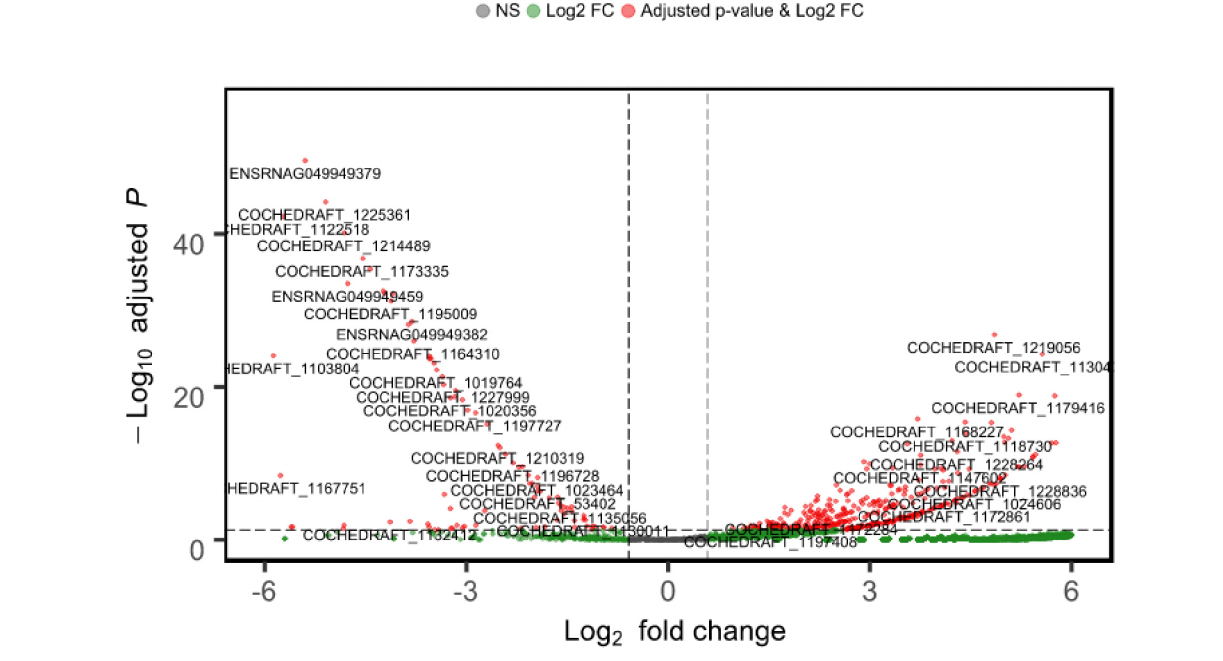
FIGURE 3 | Mean expression versus log fold change plots (MA-plots). Transcriptional changes of B. maydis are presented in SC-7 and CM 119 48 h post inoculation. Normalized P -values are plotted versus Log2 fold changes. Genes with an FDR < 0.05 are plotted.